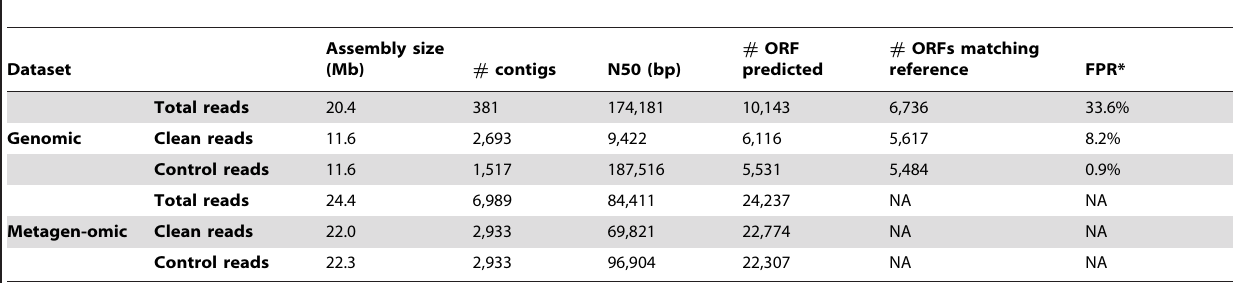
*FPR: false positive rate of the genes predicted, using S. cerevisiae as reference.